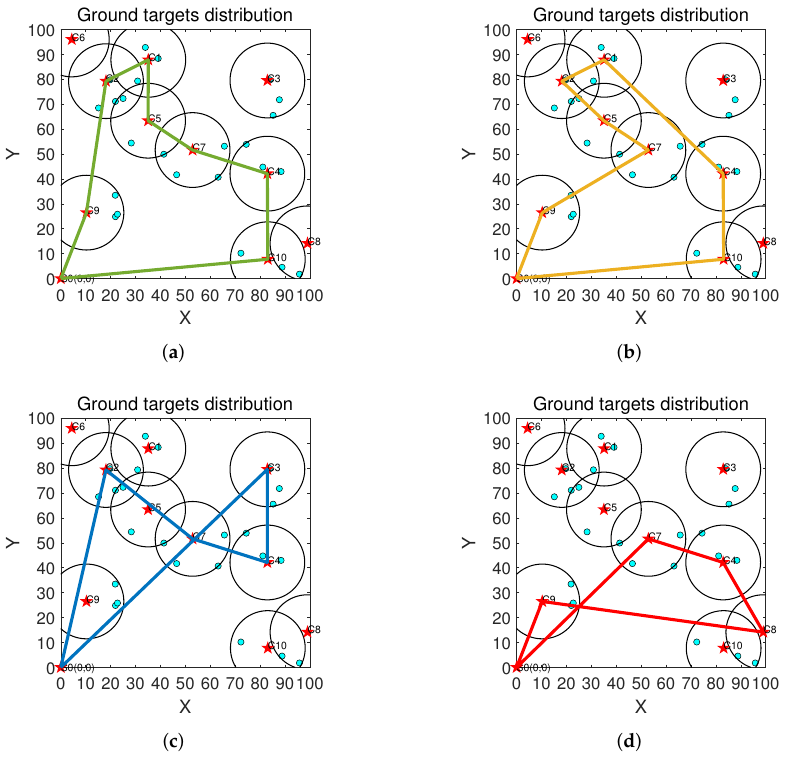
Figure 8. Trajectory planning of the UAV. ( a ) OPT algorithm; ( b ) UCR algorithm; ( c ) MSU algorithm; ( d ) RAN algorithm.